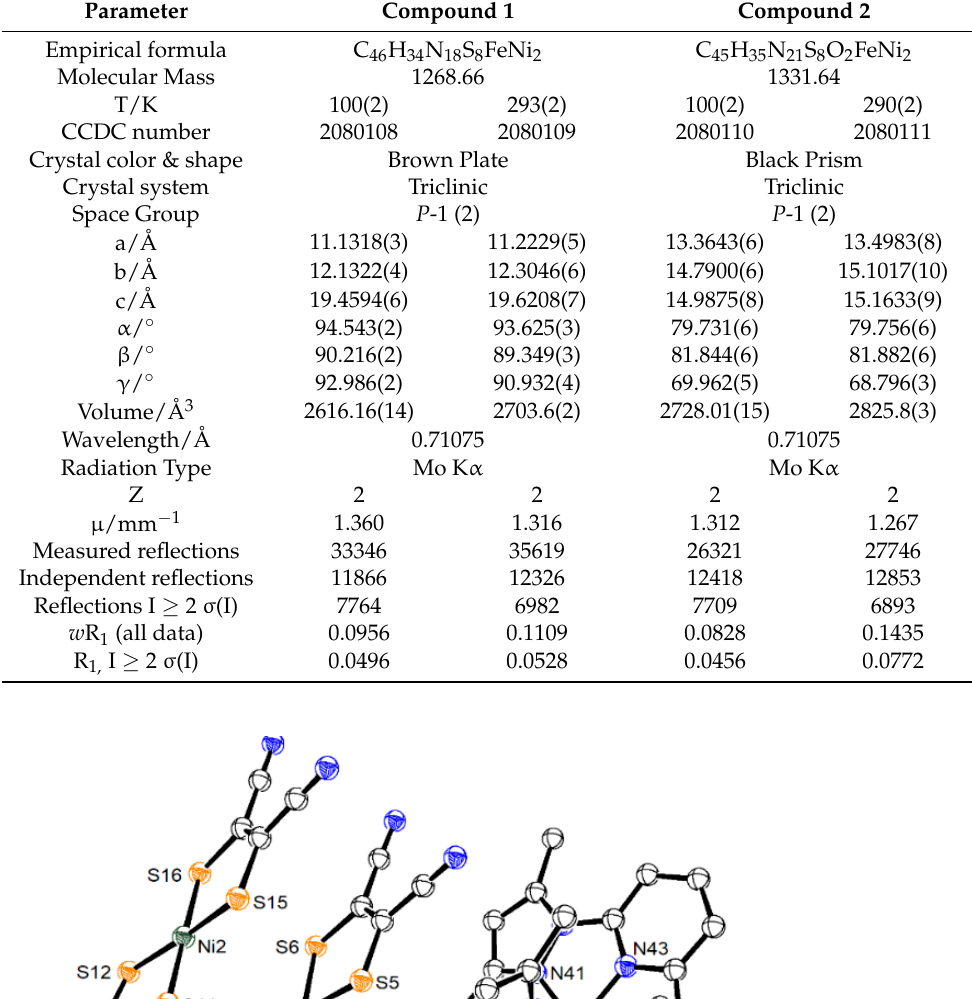
Table 1. Crystallographic data and collection parameters for compounds 1 and 2 .